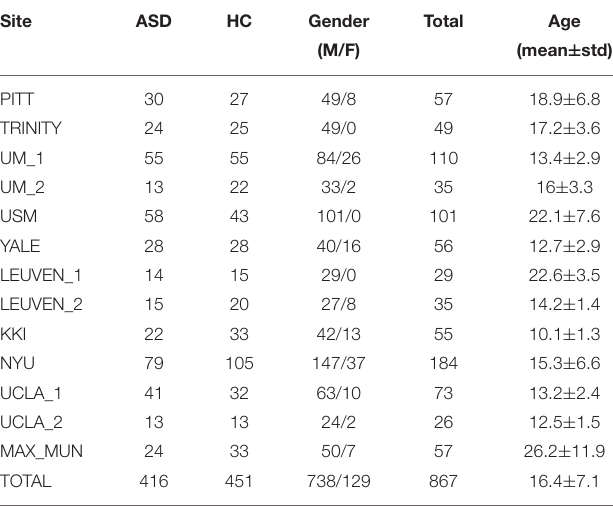
TABLE 1 | Phenotypical information summary of ABIDE